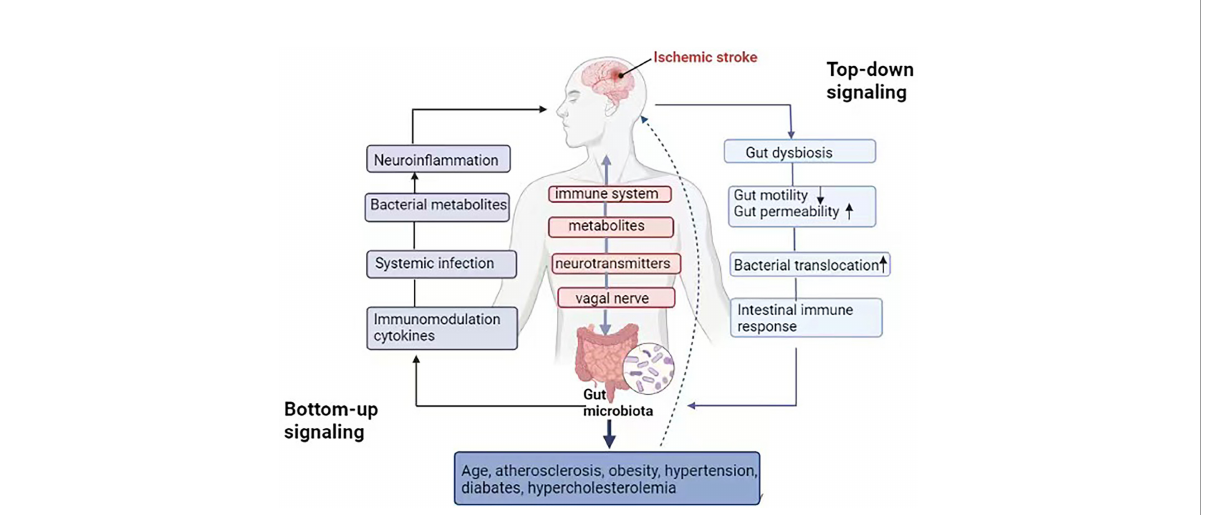
FIGURE 1 “ Microbiota-gut-brain ” axis in the ischemic stroke. Gut microbiota communicates to the CNS through the immune system, metabolites and neurotransmitters, as well as activation of the vagal nerve. In the top-down signaling pathway, ischemic stroke can affect the community structure and function of the gut microbiota through the autonomic nervous system, increase the gut permeability and reduce `gut motility, meanwhile, inducing an intestinal immune response and bacterial translocation. In the bottom-up signaling pathway, gut microbiota dysbiosis after stroke leads to changes in bacterial metabolites, systematic infection due to bacterial translocation, immune cell migration and the release of immunomodulation cytokines, which further mediate neuroin fl ammation, related to the severity of ischemic stroke and worse prognosis. Gut microbiota can affect risk factors related to ischemia stroke directly or indirectly, including hypertension, diabetes, hypercholesterolemia, obesity and atherosclerosis, as well as